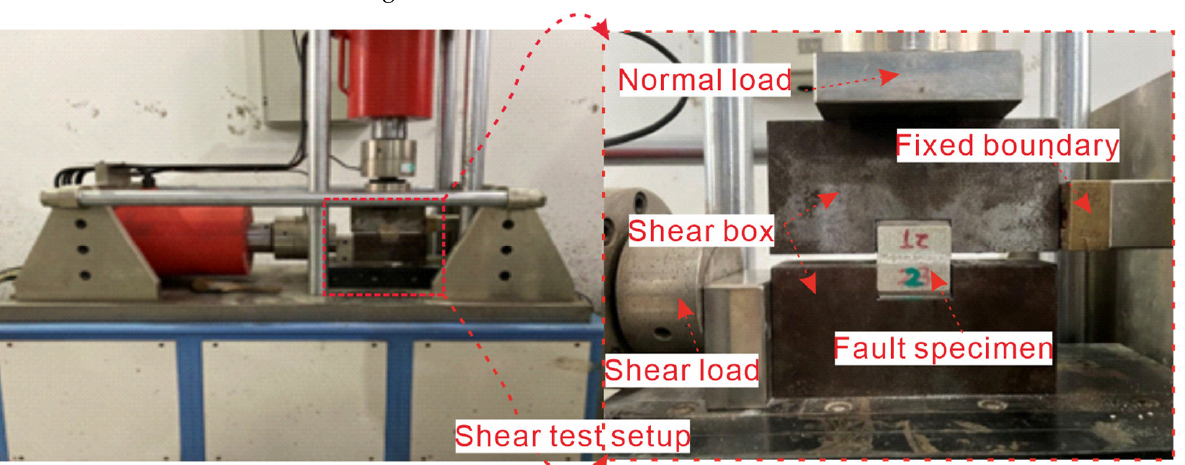
Figure 3. Initial fault plane (( a ) is the upper surface of the shear fault model, ( b ) is the lower surface of the shear fault model, ( c ) is the upper surface of the tensile fault model, ( d ) is the lower surface of the tensile fault model). It can be seen from Figure 3 that the fluctuation degree of the shear fault plane is relatively large, while the fluctuation degree of the tension fault plane is much smaller than that of the shear fault plane. To quantify the roughness of these two faults further, we use Equations (2)–(6) to calculate their fractal dimension, and the calculation results are 2.097 and 2.116, respectively, indicating that the roughness of the shear fault plane made in this paper is smaller than that of the tensile fault plane. Then, put the upper and lower fault planes on the turntable of the OKIO-5M high-precision 3D shape scanner, paste the reference points, scan, and obtain the 3D point cloud data of the fault plane after scanning. Import the point cloud data into the high-precision engraving machine and en- grave a batch of fault rock samples containing real shear faults with the same shape and